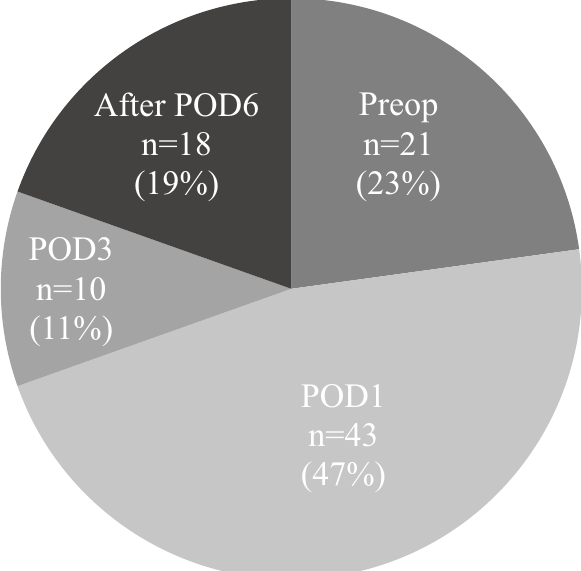
Figure 1. The timing of postoperative hyponatremia is